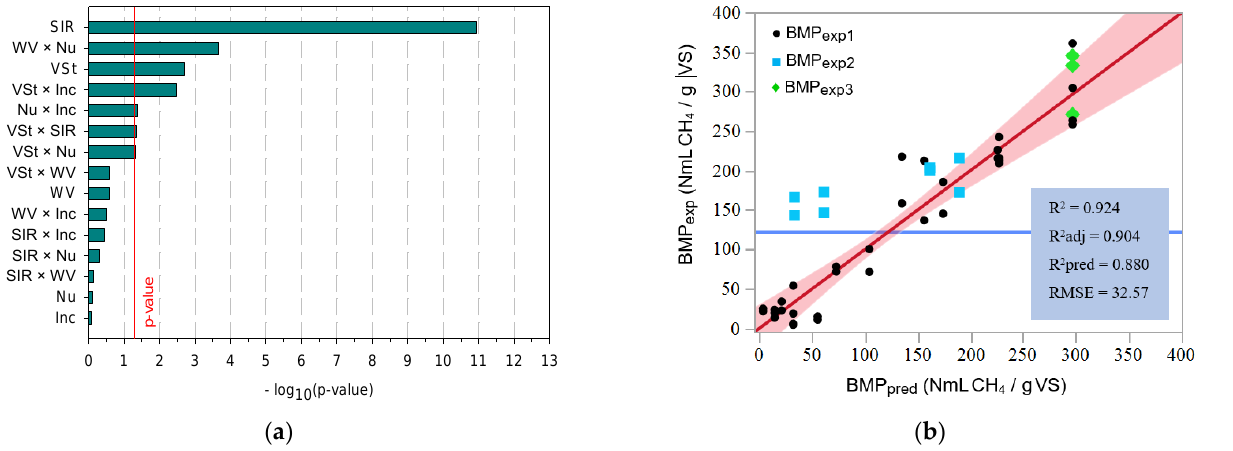
Figure 2. ( a ) Statistical significance of the terms included in the complete 2nd-order factorial model. ( b ) Comparison between predicted and experimental BMP values obtained from the 2 5 − 1 fractional factorial design. Table 3. Second-order factorial model for BMP (NmL CH4 /g VS ) prediction through the operating conditions of anaerobic